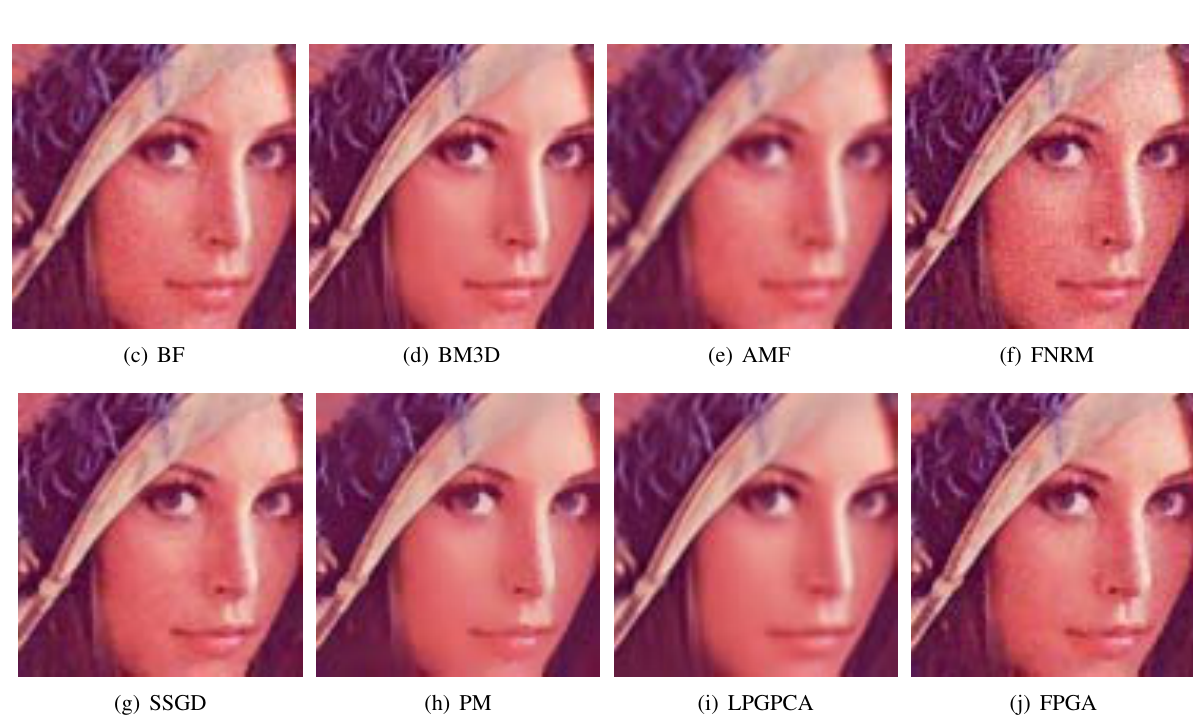
Fig. 1 Results under different smoothing methods applied to Lenna image corrupted by a Gaussian noise with standard deviation σ =